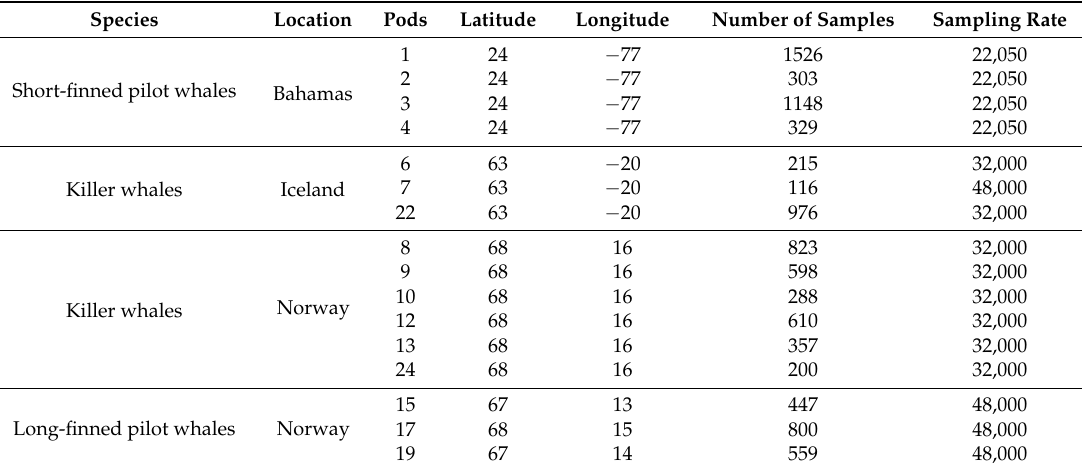
Table 1. List of recordings of whale